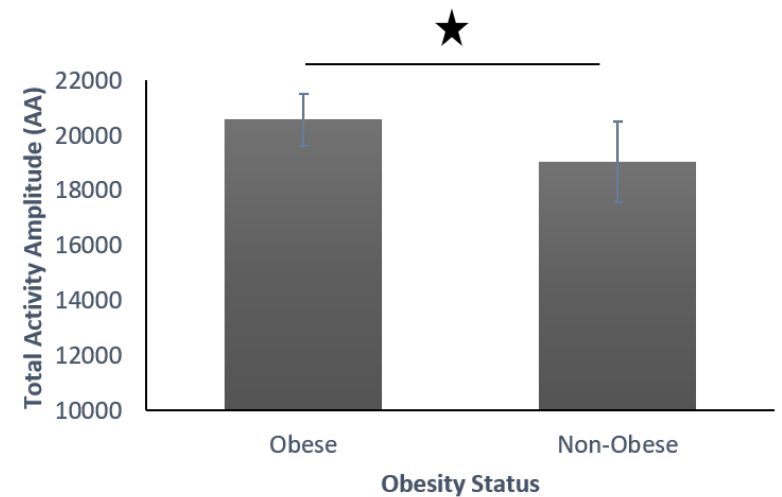
Figure 12. Total activity amplitude (AA) with low, medium, and high amplitudes among obese and non-obese participants.